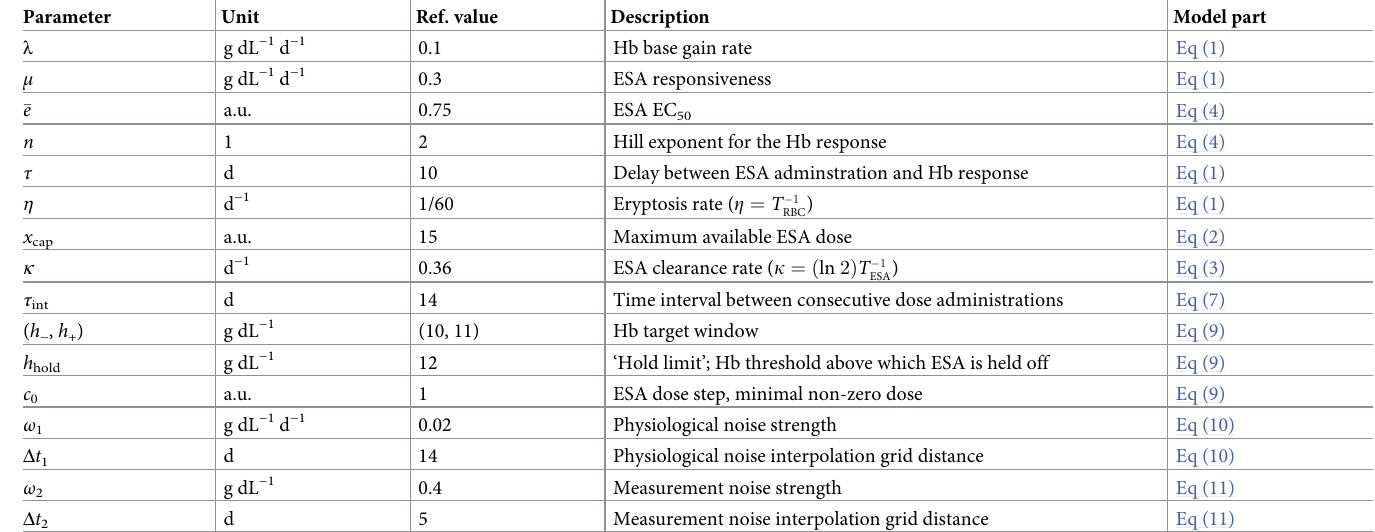
Table 1. List of reference model